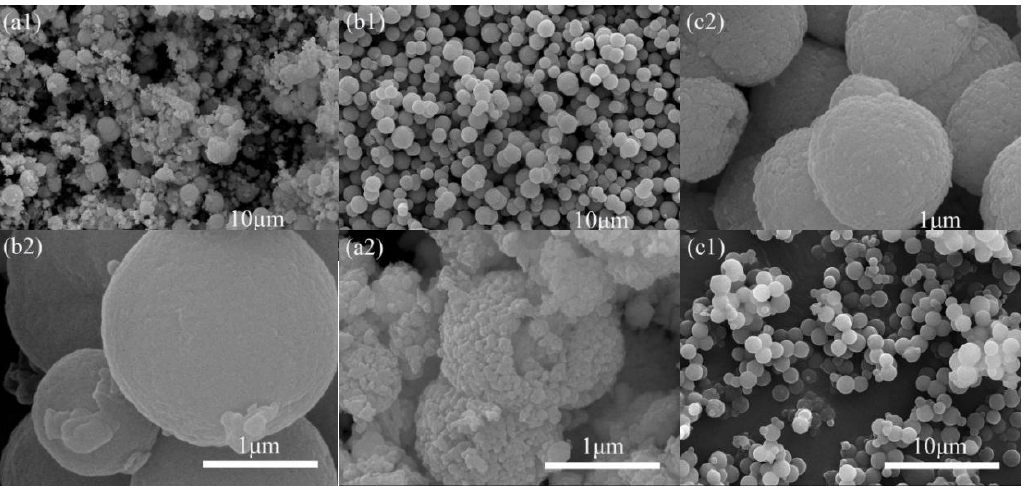
Figure 8. SEM images of the MOCs synthesized at ( a1 , a2 ) 50 °C; ( b1 , b2 ) 55 °C; and ( c1 , c2 ) 65 °C.